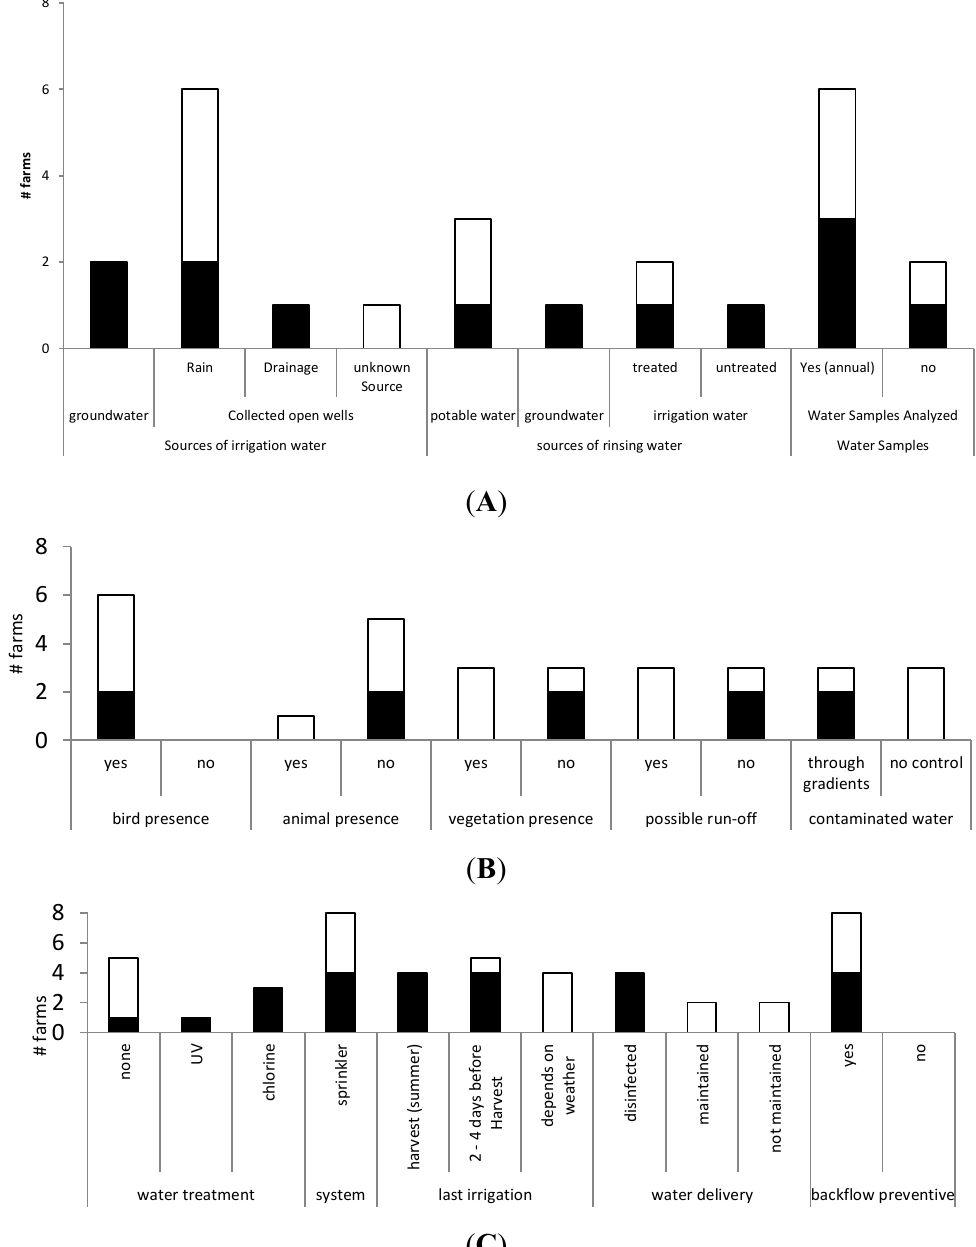
Figure 2. Results of the water management questionnaire (Appendix); black boxes, greenhouses; white boxes, open field farms. A : Water sources applied for irrigation, sources of rinsing water, and microbial analysis of the applied water. B : Measures taken to prevent contamination routes; farms 3 and 4 were omitted because borehole water was used. C : Irrigation method/applied water treatment; y -axis, number of